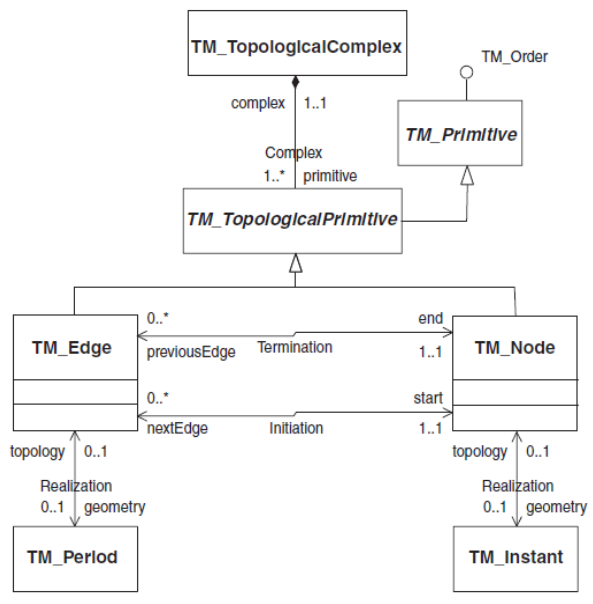
Figure 3 Topology of time (ISO, 2002)